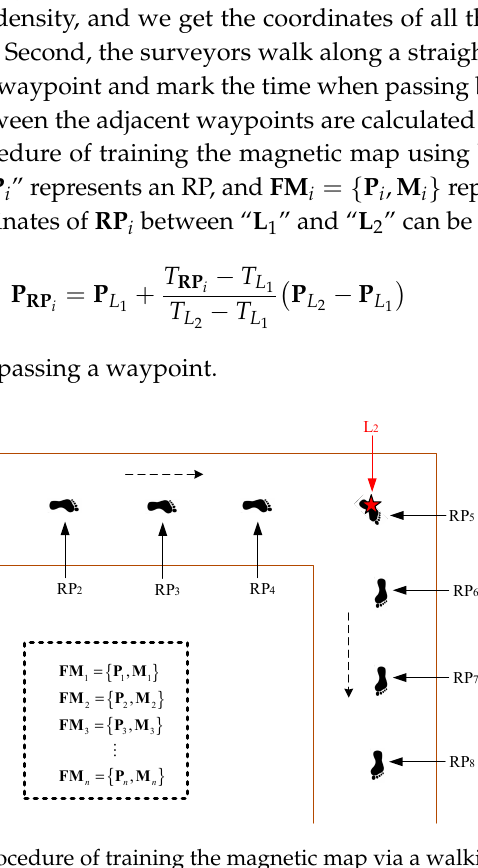
Figure 4. The designed trajectories for building a magnetic field map.